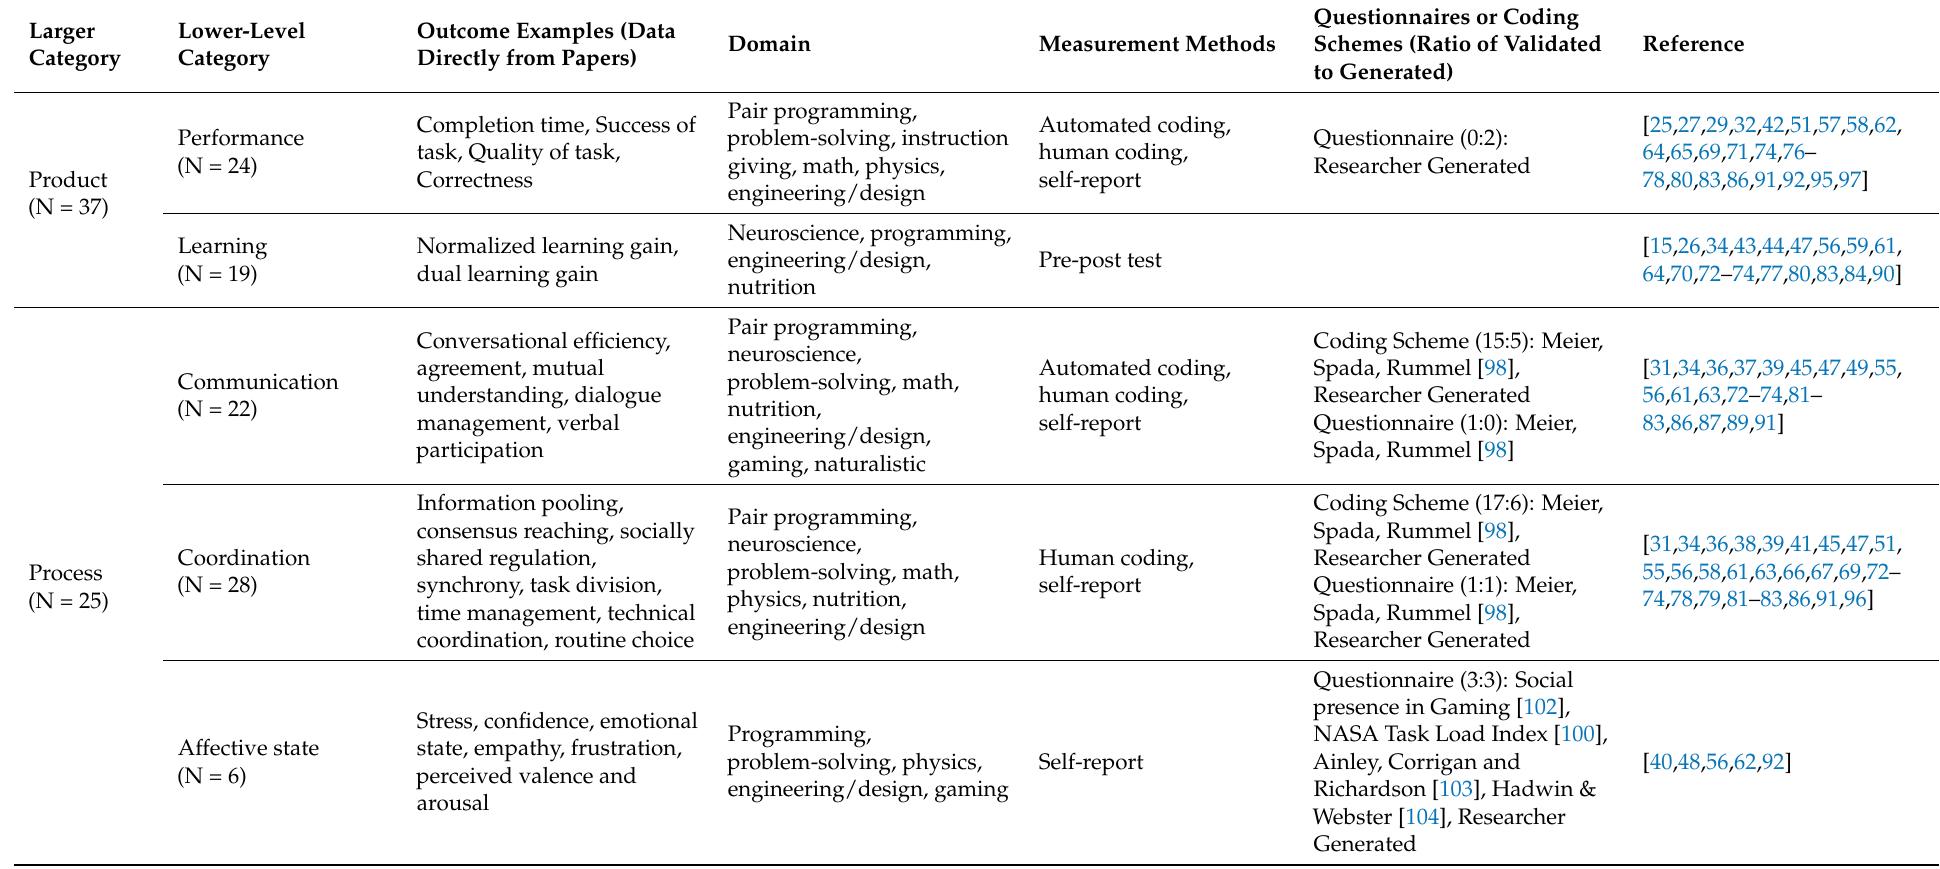
Table 2. Taxonomy of